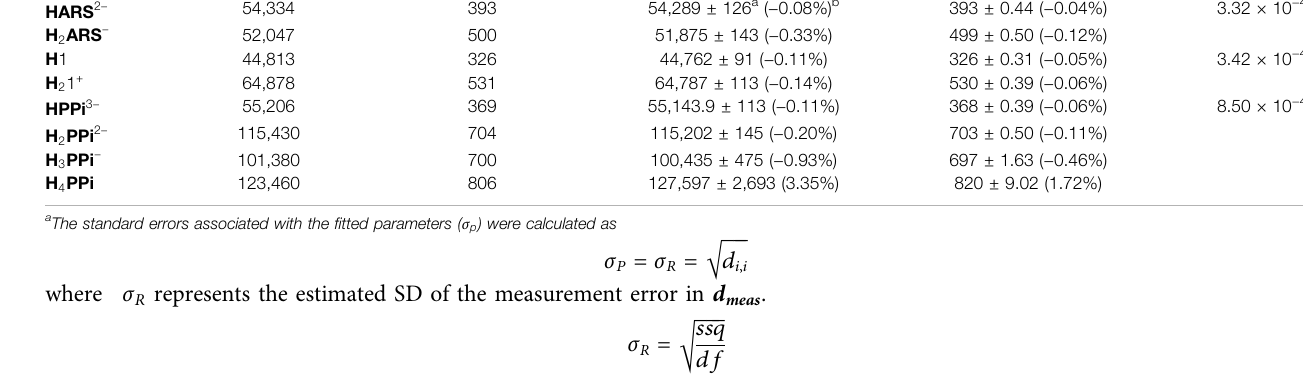
TABLE 2 | Obtained thermodynamic constants for the simulated pH datasets corresponding to ARS, 1 and PPi. Used to construct data CalculatedSpecies Δ H (J/mole) Δ S (J/mole.K) Δ H (J/mole) Δ S